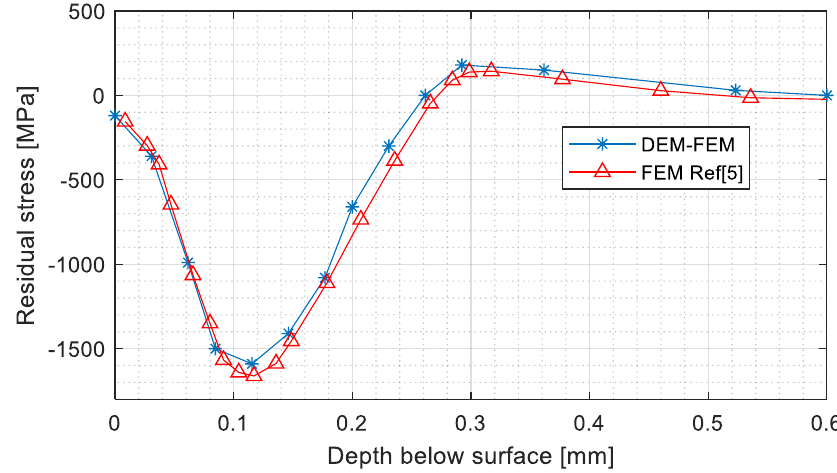
Figure 8. Residual stress profile for a single shot of 0.7 mm diameter at 50 m/s onto a target made of AISI 4340. Showing the current DEM-FEM result and FEM result recreated from the literature [5].